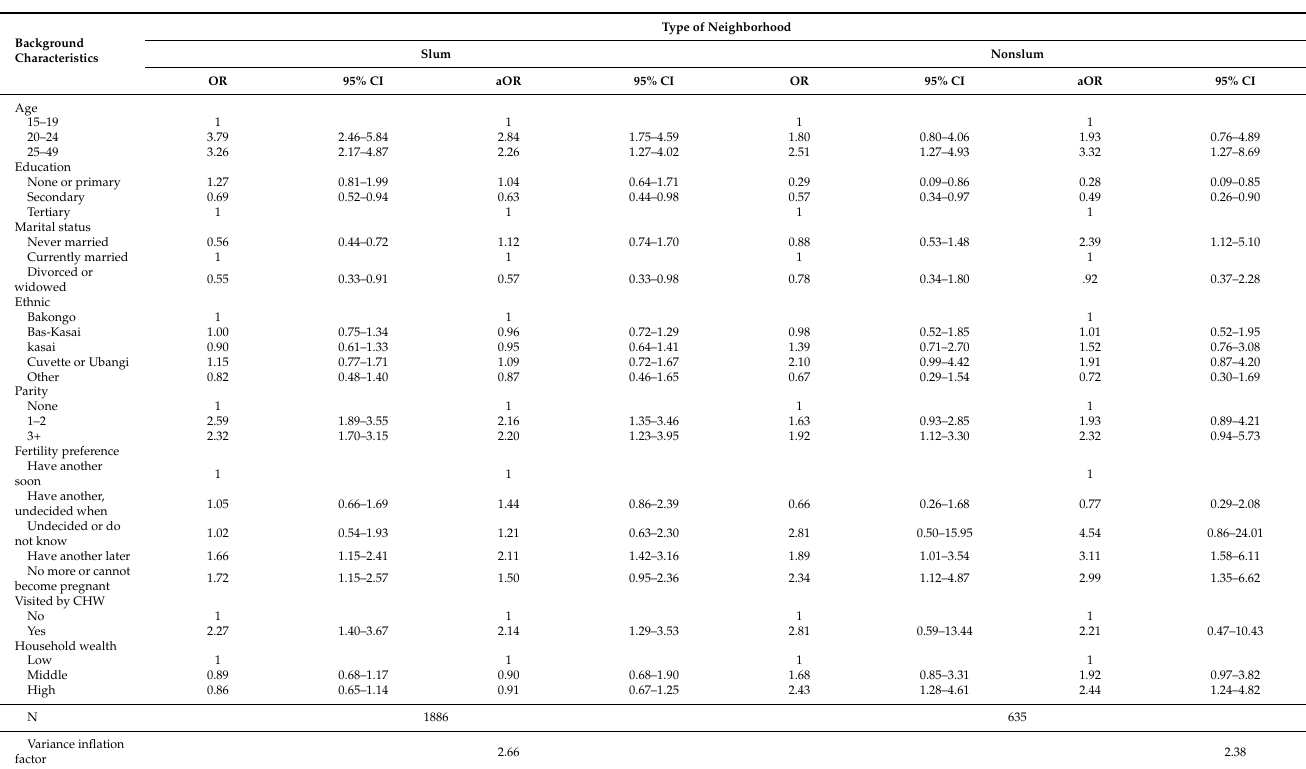
Table 5. Results of logistic-regression models of modern contraceptive use among women aged 15–49, Kinshasa, 2020, stratified by type of